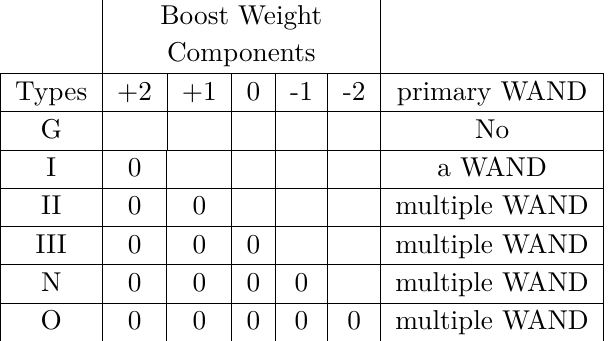
Table 1 . Higher dimensional classification of a spacetime with obligatory vanishing components of boost